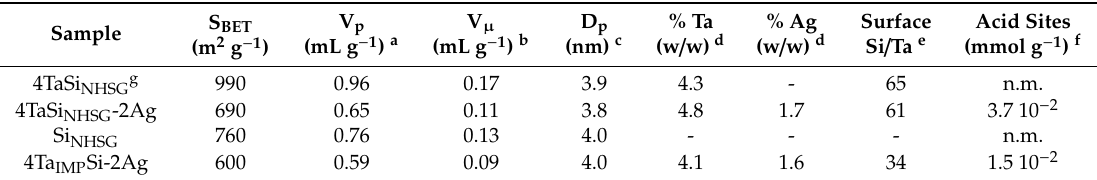
Figure 1. N 2 -physisorption isotherms of 4TaSi NHSG ( Δ ), 4TaSi NHSG -2Ag ( ○ ), Si NHSG ( ◊ ), and 4Ta IMP Si-2Ag ( × ). Adsorption isotherms are plotted as solid lines, desorption isotherms are plotted as dotted lines. NHSG, non-hydrolytic sol-gel. Table 1. Textural properties (N 2 -physisorption) and analysis of composition (ICP-OES), surface composition (XPS) and surface acidity (NH 3 -TPD) for the catalysts prepared with a 4 wt.% Ta loading either by NHSG or dry impregnation (IMP).